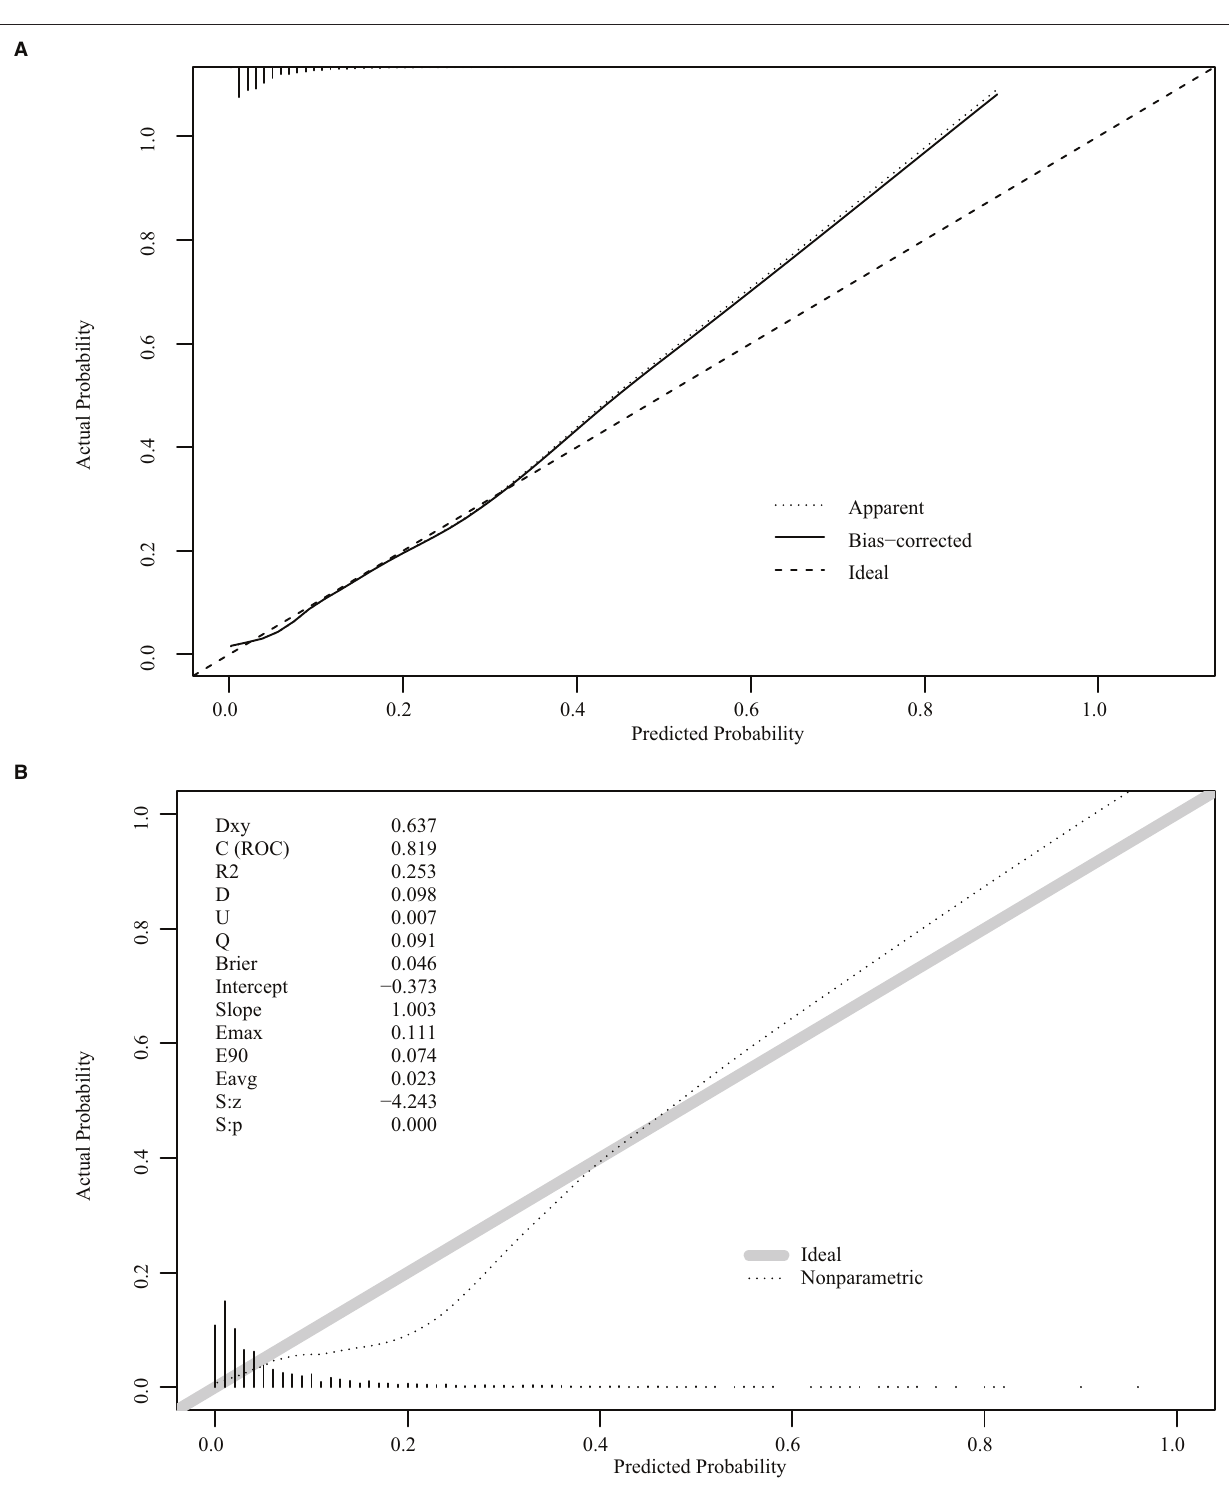
Frontiers in Medicine |